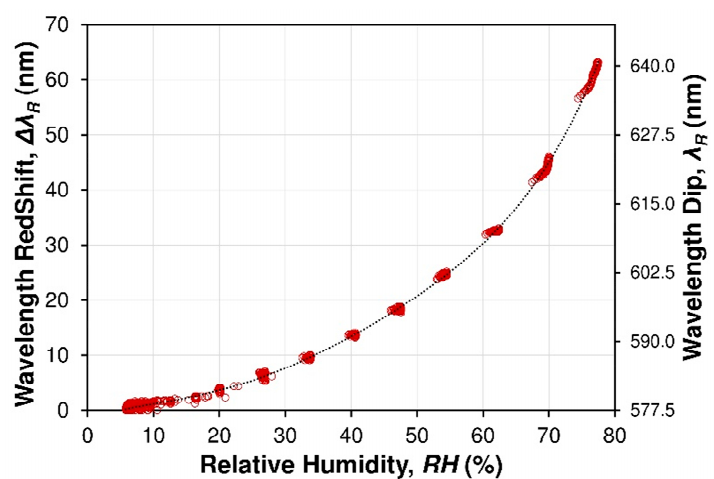
Figure 11. Resonant wavelength λ R and wavelength red shift ∆ λ R of the dark fringe (central spectra region from Figure 9) vs RH. Points (red) are the experimental data; solid line (black): calibration curve given by fitting. Experimental reference measurements of RH% detection through the commercial SHT75 humidity sensor.